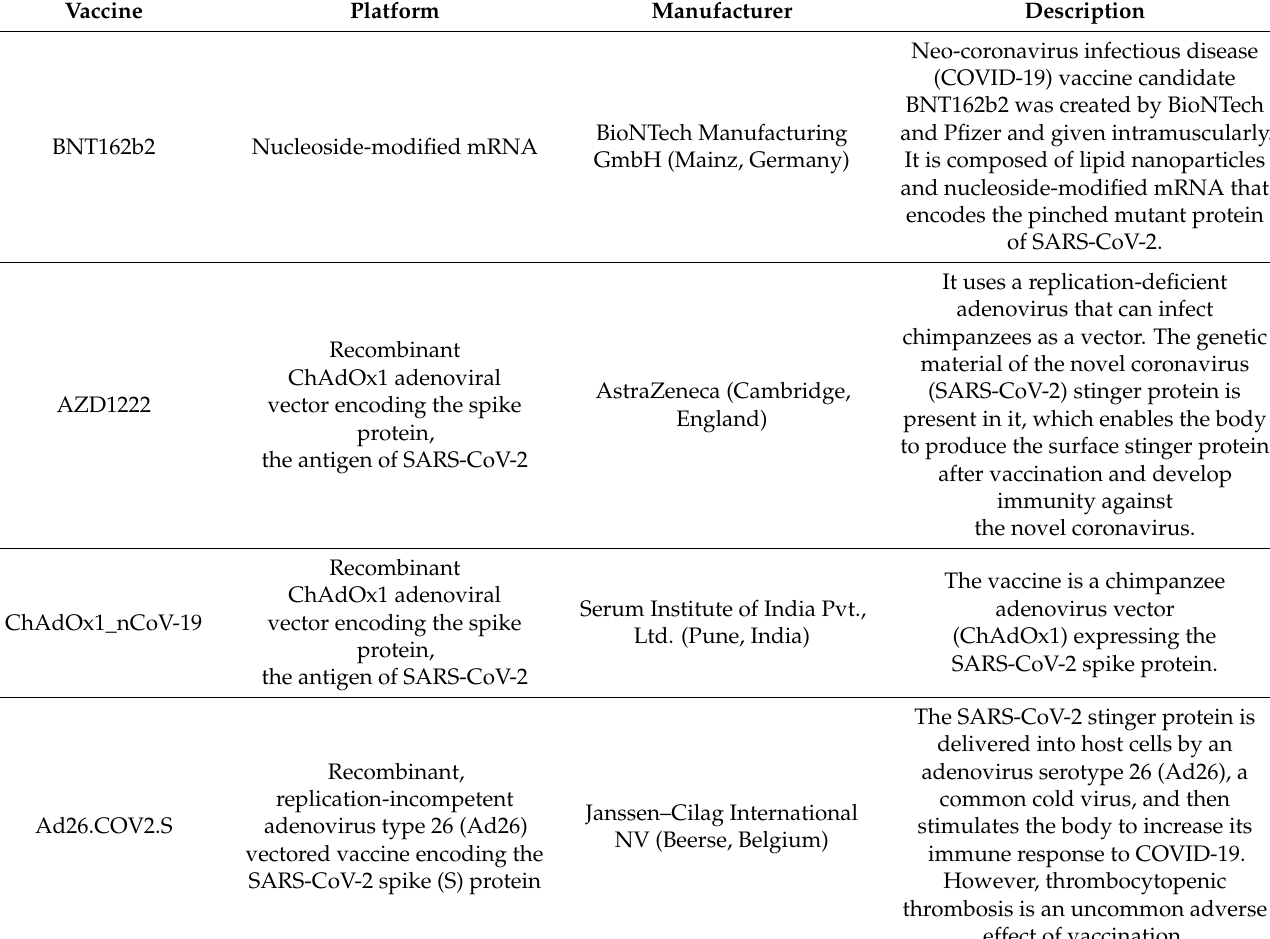
Table 1. Summary of some SARS-CoV-2